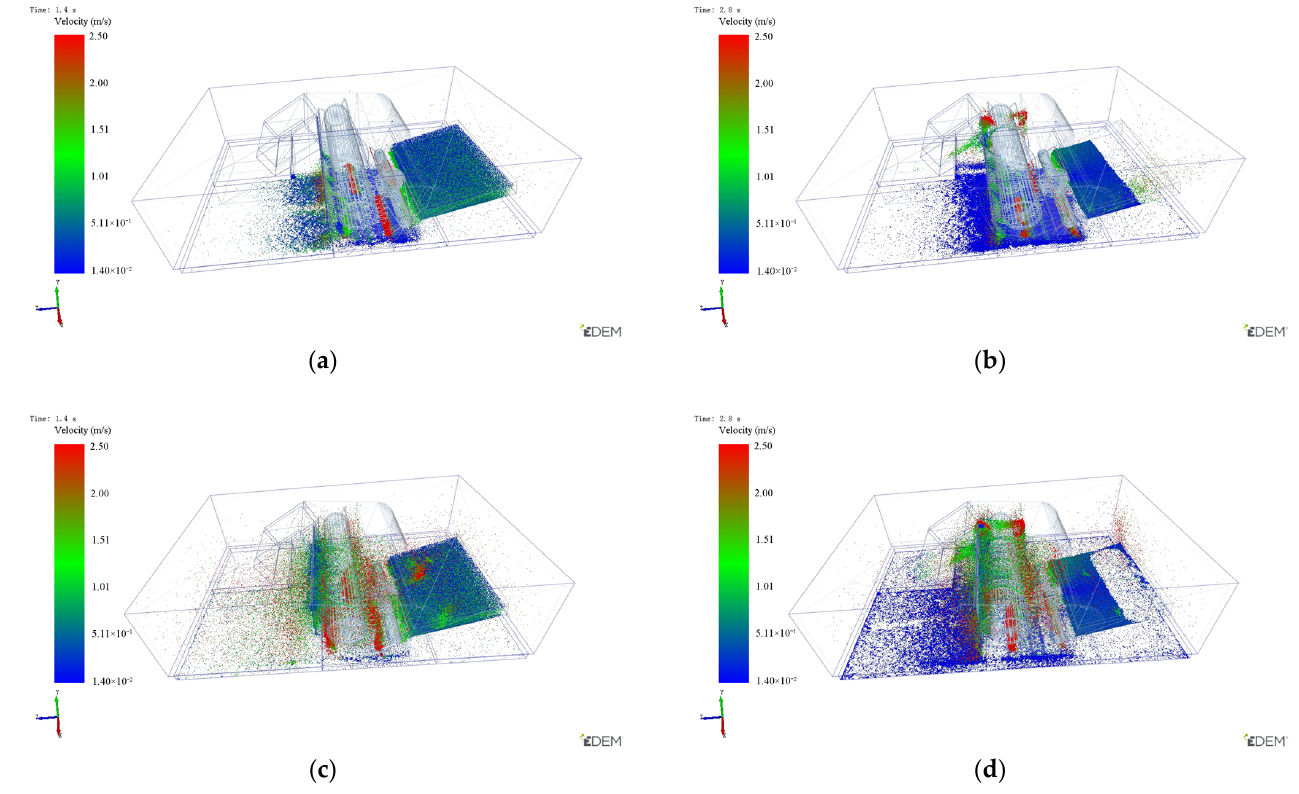
Figure 8. Velocity simulation comparison diagram: ( a ) without vibratory action at 1.4 s; ( b ) without vibratory action at 2.8 s; ( c ) with vibratory action at 1.4 s; ( d ) with vibratory action at 2.8 s.